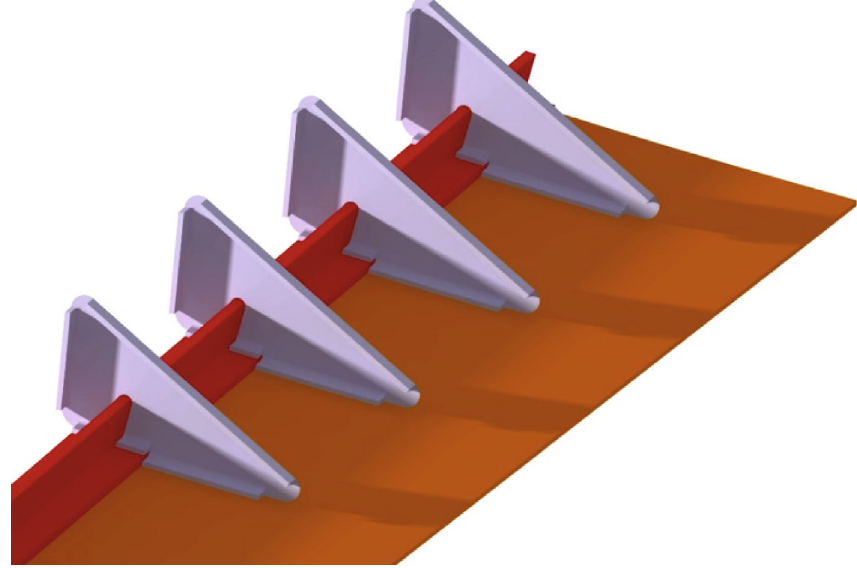
Figure 17: Support structure for the removable inspection